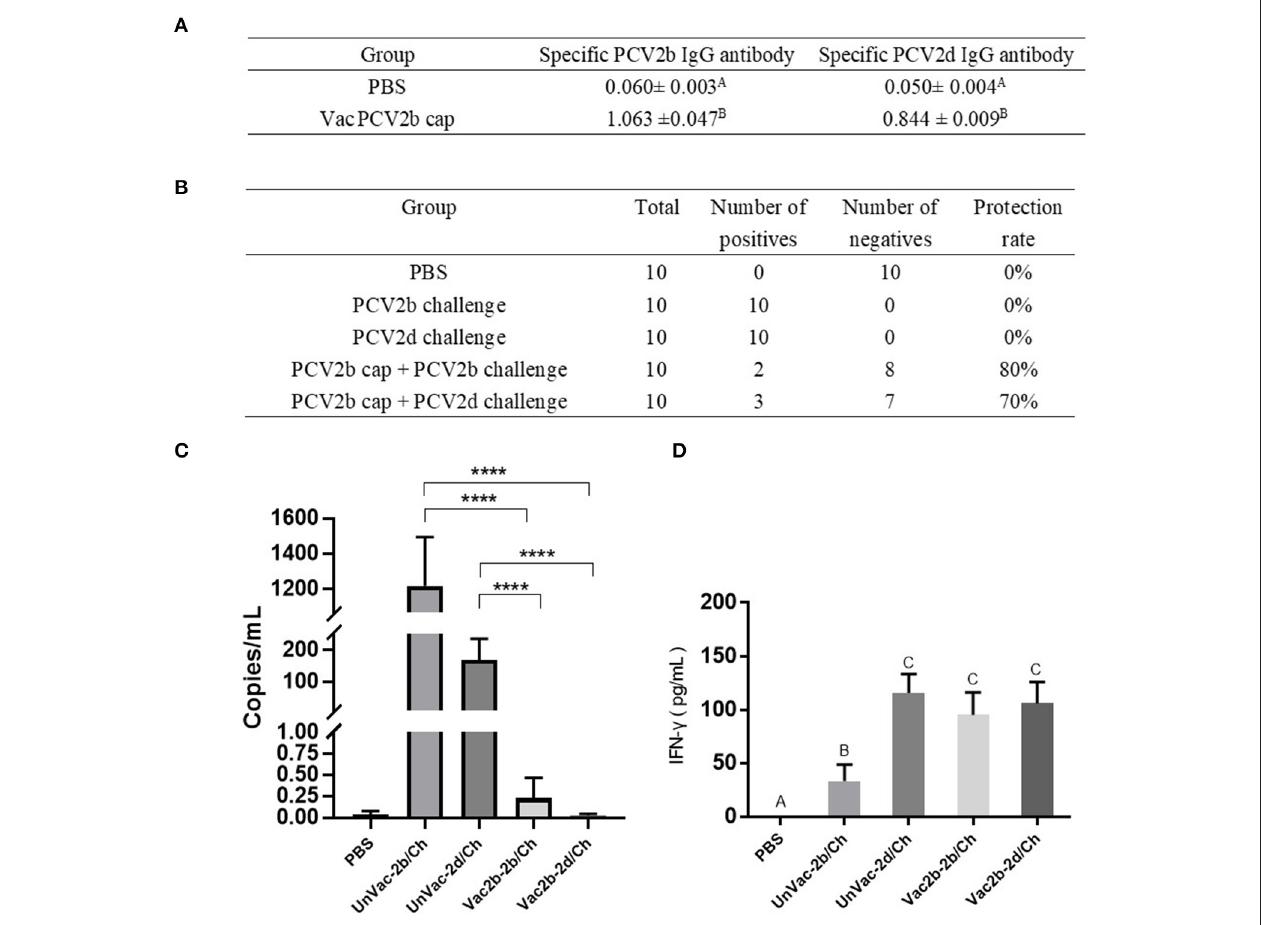
FIGURE 6 | Homologous and heterologous immune response of PCV2d Cap protein against the PCV2b and PCV2dagainst the PCV2b and PCV2d. (A) Specific antibody levels for PCV2b and PCV2d Cap proteins at 0 dpc. (B) Detection of PCV2 DNA in serum by PCR at 14 dpc. (C) Detection of the PCV2 DNA load in serum by RT-PCR at 14 dpc. (D) Levels of IFN- γ in blood at 14 dpc. The data are presented as group mean optical density (M OD ± standard error). Significant differences are indicated by different superscripts (A–C) ( p < 0.05). Data were analyzed using one-way analysis of variance with Dunnett’s multiple comparisons test using GraphPad Prism 7 software (GraphPad Software, USA), **** p <